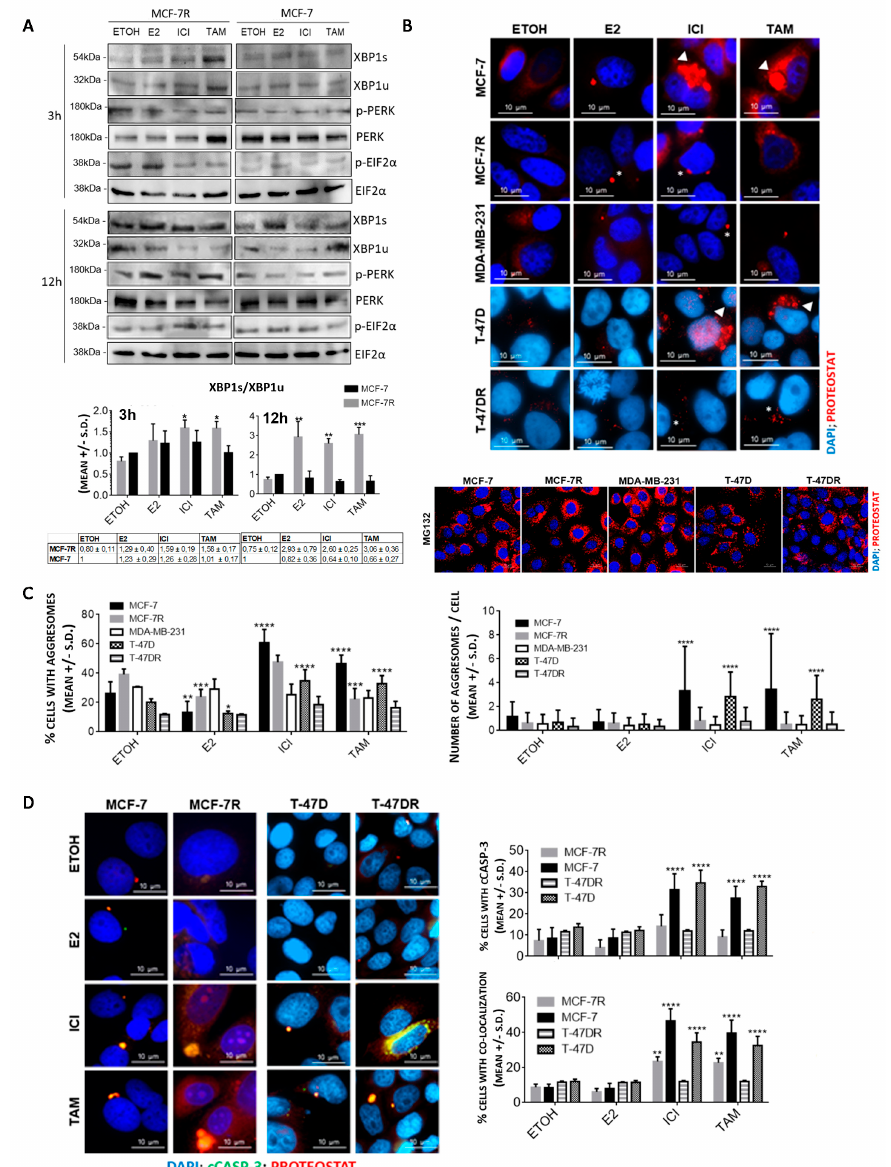
Figure 1. Characterization of antiestrogen-induced protein aggregation clearance and accumulation in breast cancer cell lines. ( A ) Western blot showing XBP1s/XBP1u ratio and activation of PERK/EIF2 α UPR branch after exposure to 10 nM 17 β -estradiol (E2), 250 nM Fulvestrant (ICI) or 500 nM 40HO-tamoxifen (TAM). * p < 0.05; ** p < 0.01; *** p < 0.001 vs. ETOH in the same cell line. Blots are representative of two experiments. ( B ) Comparative analysis of protein aggregation levels in MCF-7, MCF-7R, MDA-MB-231, T-47D and T-47DR cell lines. Staining with Proteostat ® was carried out after 24 h treatment with 10 nM E2, 250 nM ICI, 500 nM TAM or 5 µ M MG132 (positive control for protein aggregation). Arrowheads: cytoplasmatic localization; star: juxtanuclear region. ( C ) The graphs summarize results from at least three independent experiments, as shown in ( D ), with a total of 10,000 cells counted. **** p < 0.0001, *** p < 0.001, ** p < 0.01; vs. same cell line ETOH. D. Proteostat ® and cleaved caspase-3 (cCASP-3) were colocalized by a double ICC after 24 h incubation with 10 nM E2, 250 nM ICI, 500 nM TAM. **** p < 0.0001, ** p < 0.01 vs. same cell line ETOH. Representative of at least two experiments. In all cases, the cells received the same concentration of solvent (absolute